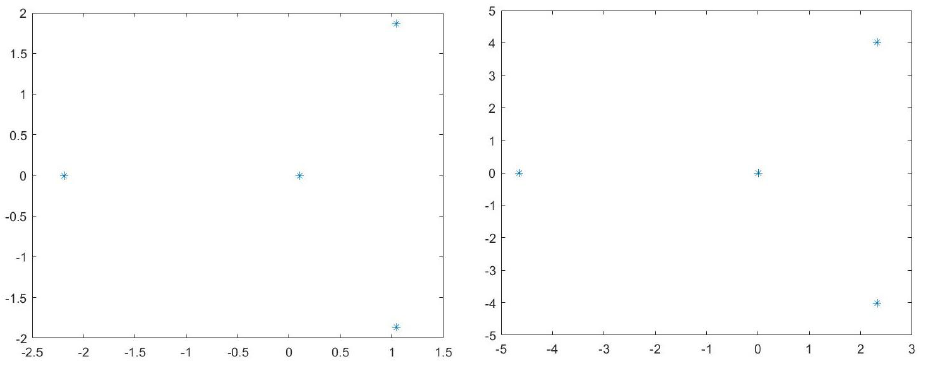
Figure 4. Idem for λ = − 100 ( left ) and λ = − 1000 ( right ). To this end, a = 1, with χ 1 < (cid:101) → 0 and